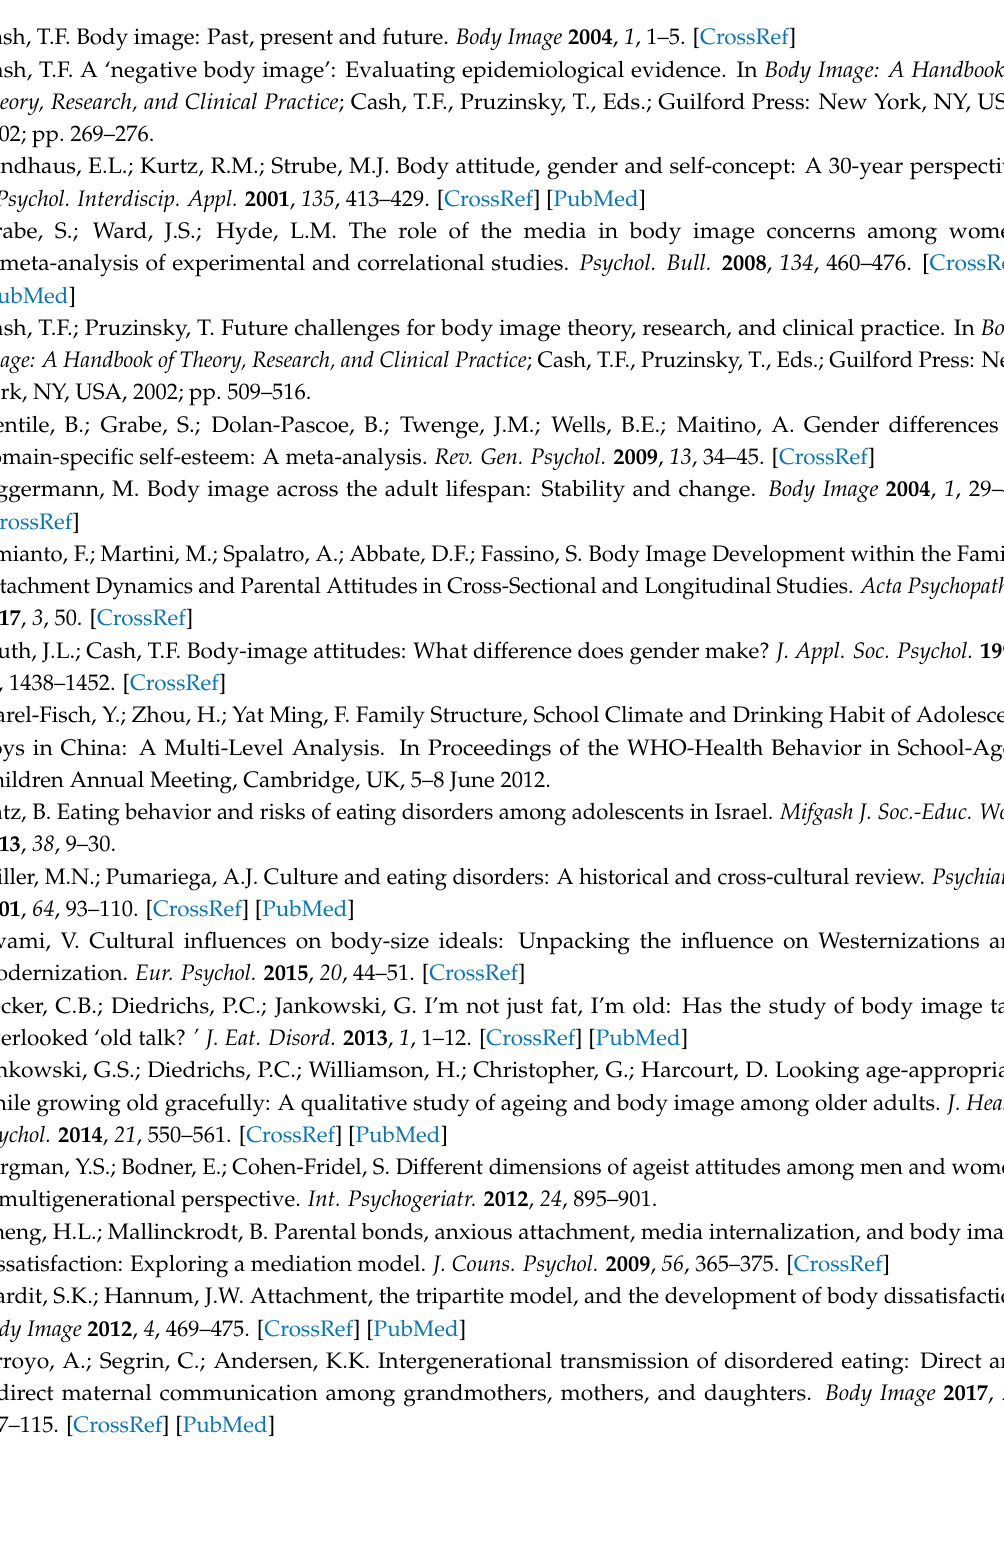
Section III: Impact of body image and appearance on workers’